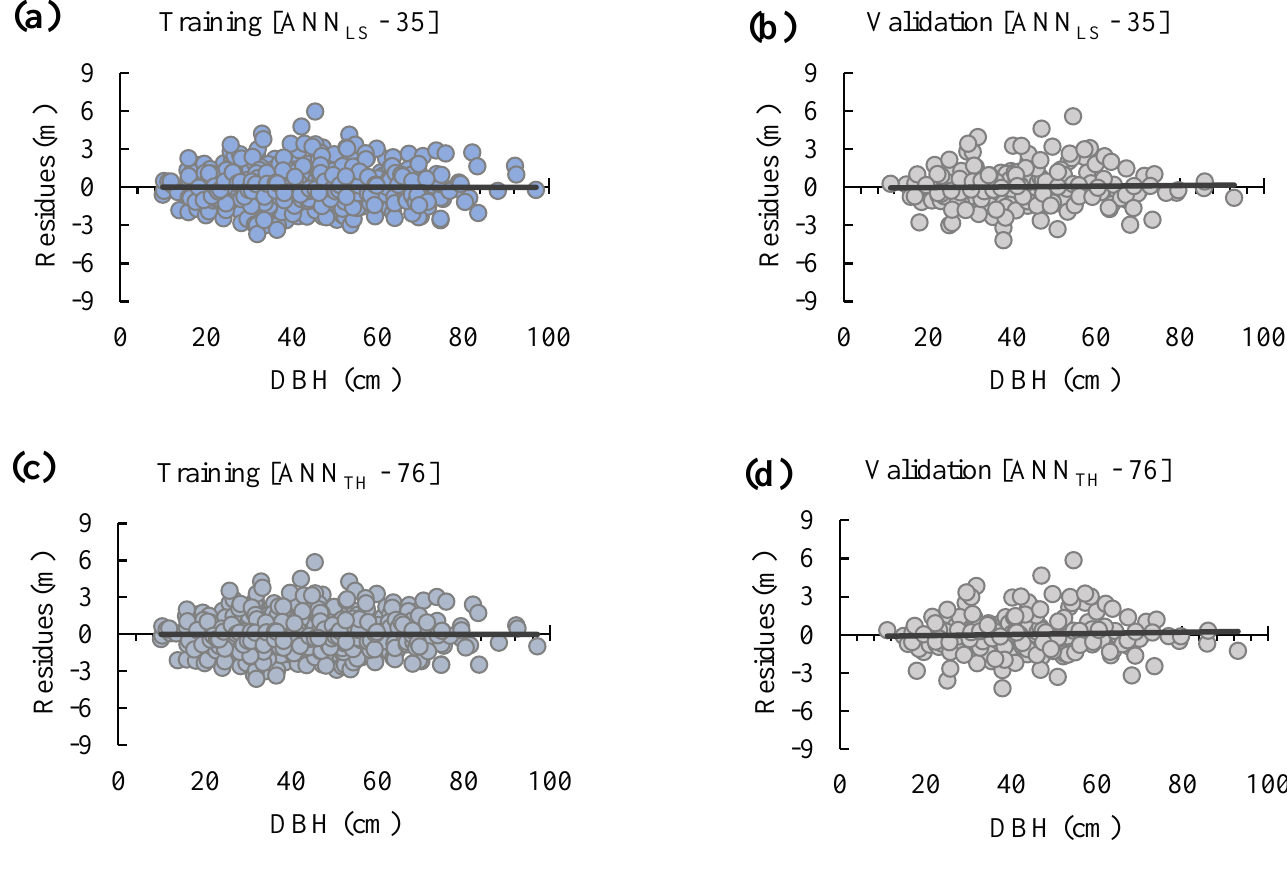
Figure 4. Residual distribution of the best-trained networks (ANN LS -35 and ANN TH -76) to describe the height of Brazilian pine trees in mixed forests. ( a ) and ( c ) correspond to the training set; ( b ) and ( d ) correspond to the validation set.